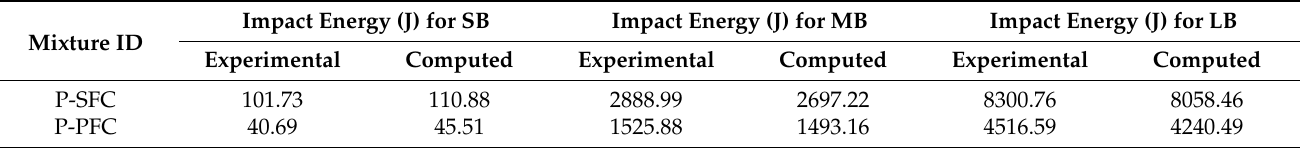
Table 5. Impact energy comparison (experimental and computed